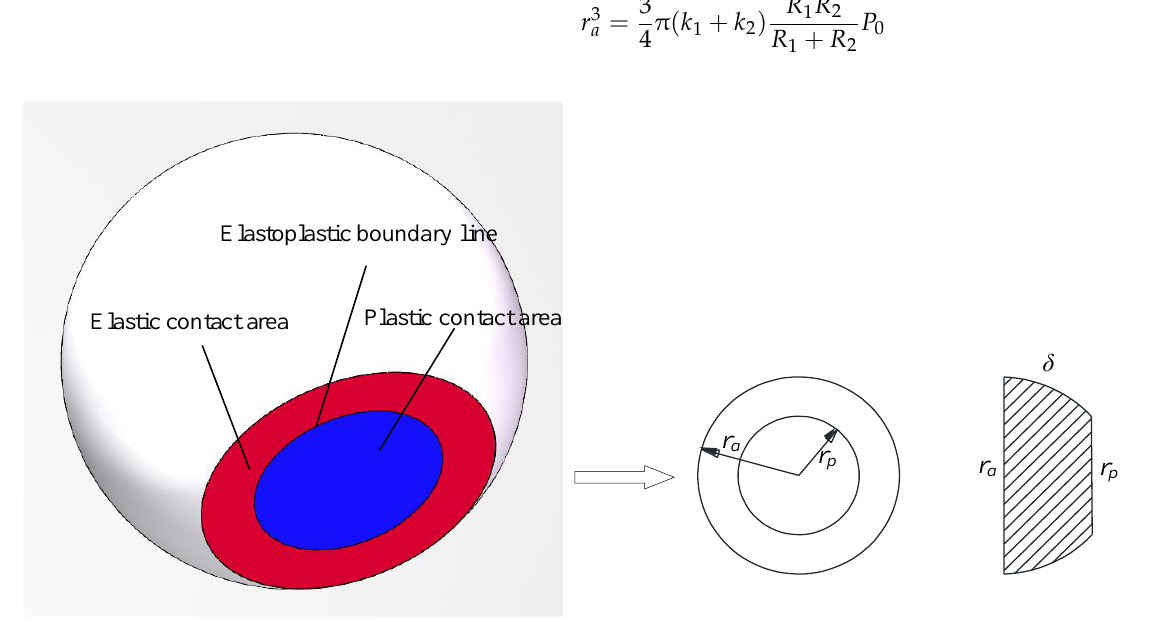
Figure 1. The elastoplastic collision model of particles.